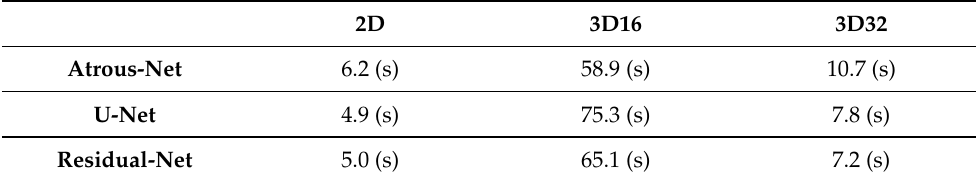
Table 15. Synthesis Times for Head. Average time in seconds to synthesize a whole volume from the Head data set using 2D networks and 3D networks reconstructing with stride 16 and